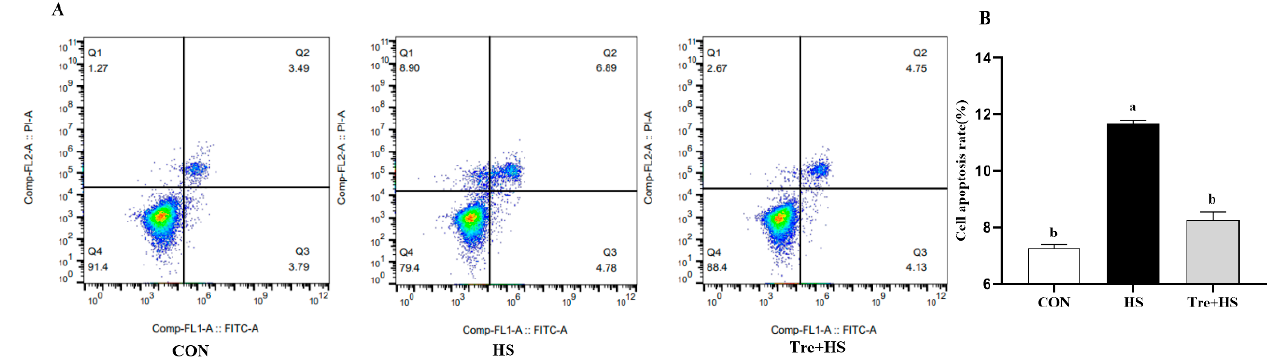
Figure 5. Effects of trehalose on apoptosis in heat-stressed IPEC-J2 cells. IPEC-J2 cells were cultured at 37 ◦ C until the end of the experiment (control, CON); exposed to heat stress for 2 h (43 ◦ C, HS); or pretreated with 10 mM trehalose at 37 ◦ C for 4 h prior to heat stress exposure for 2 h (Tre + HS). Cell apoptosis was measured by annexin V-fluorescein isothiocyanate/propidium iodide staining and flow cytometry assay ( A , B ). Data are shown as mean ± SD (n = 3). Means for variables that do not share a common letter differ significantly ( p < 0.05).